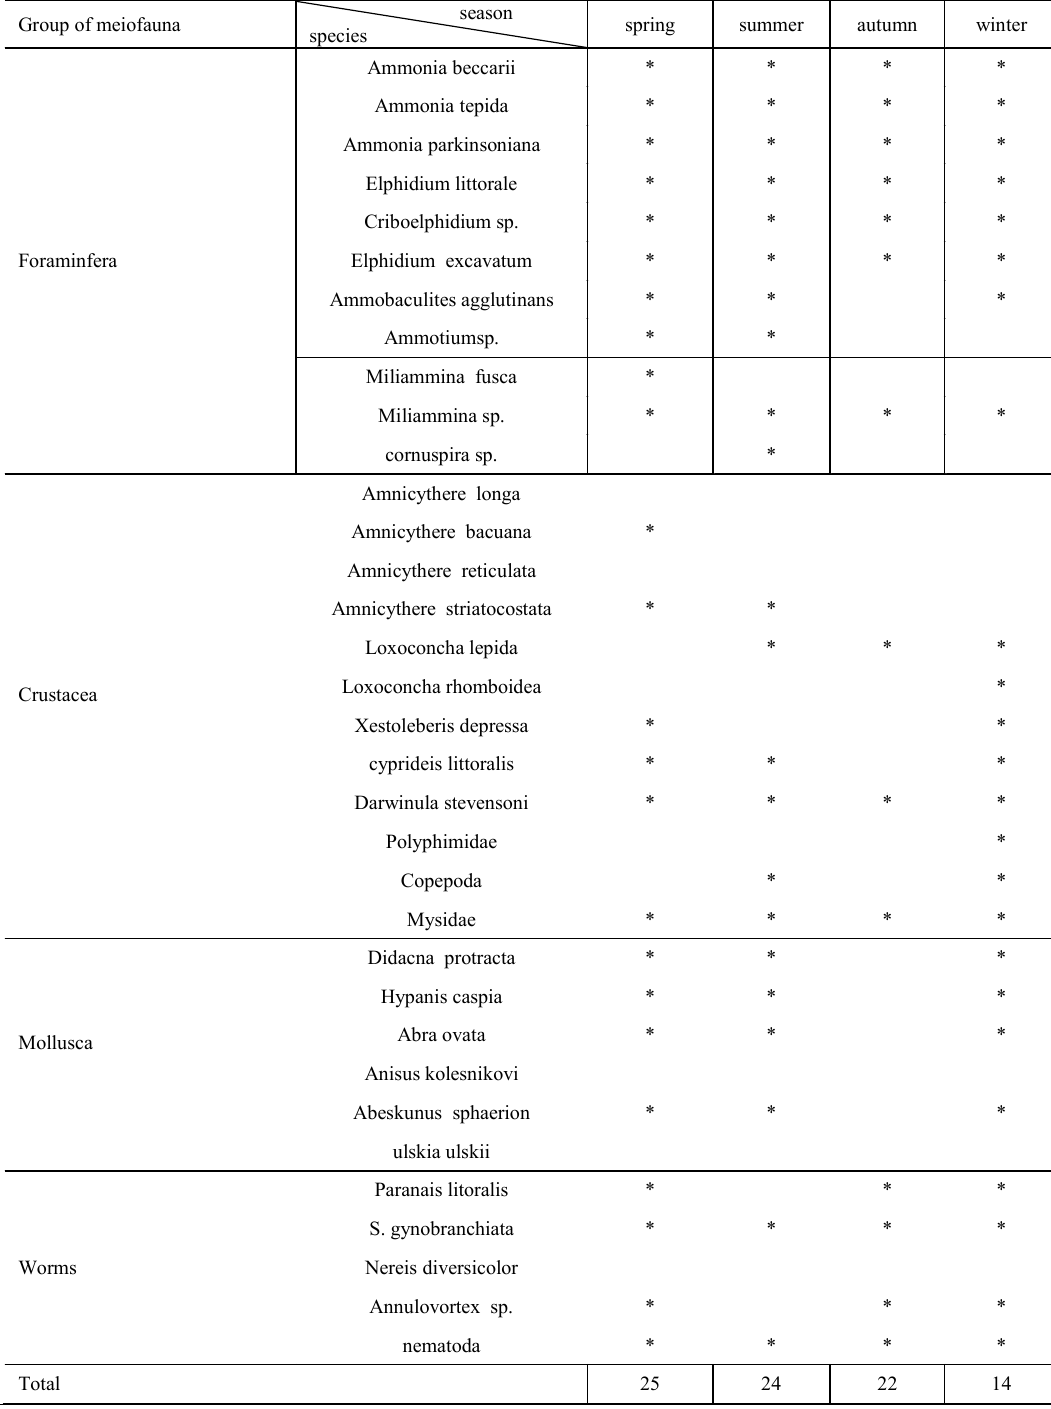
Table 11: Living identified species of meiofauna in the southern Caspian Sea from Behshahr to Ramsar in different seasonss. Group of